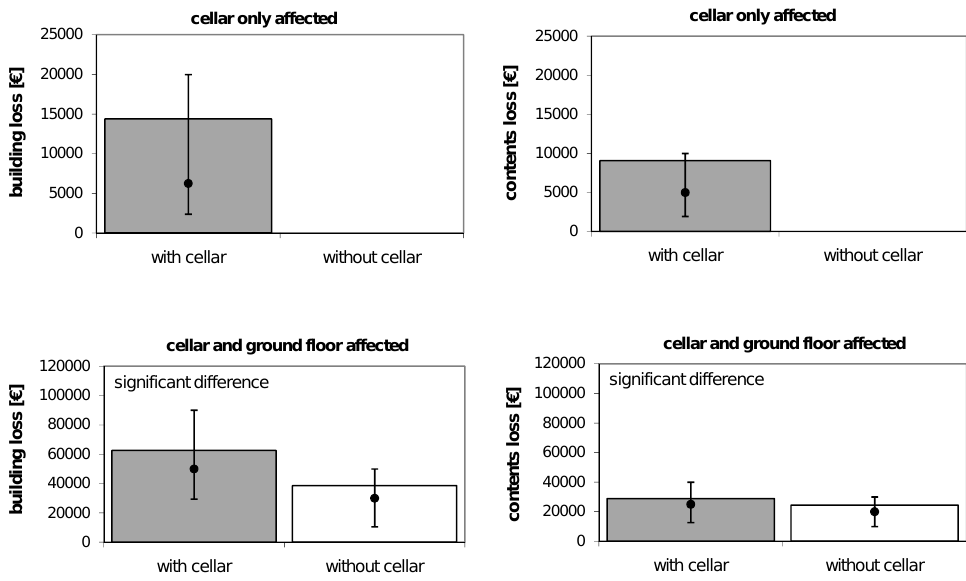
Fig. 2. Differences in building and contents damages between buildings with or without cellars, separated into cases where only cellars were affected and cases where ground floors also were affected (bars=means, points=medians and 25–75% percentiles, significant differences between the cases with/without cellar are